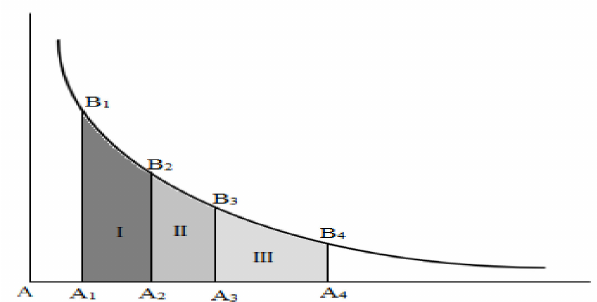
Figure 4. Relationship between successive lengths.